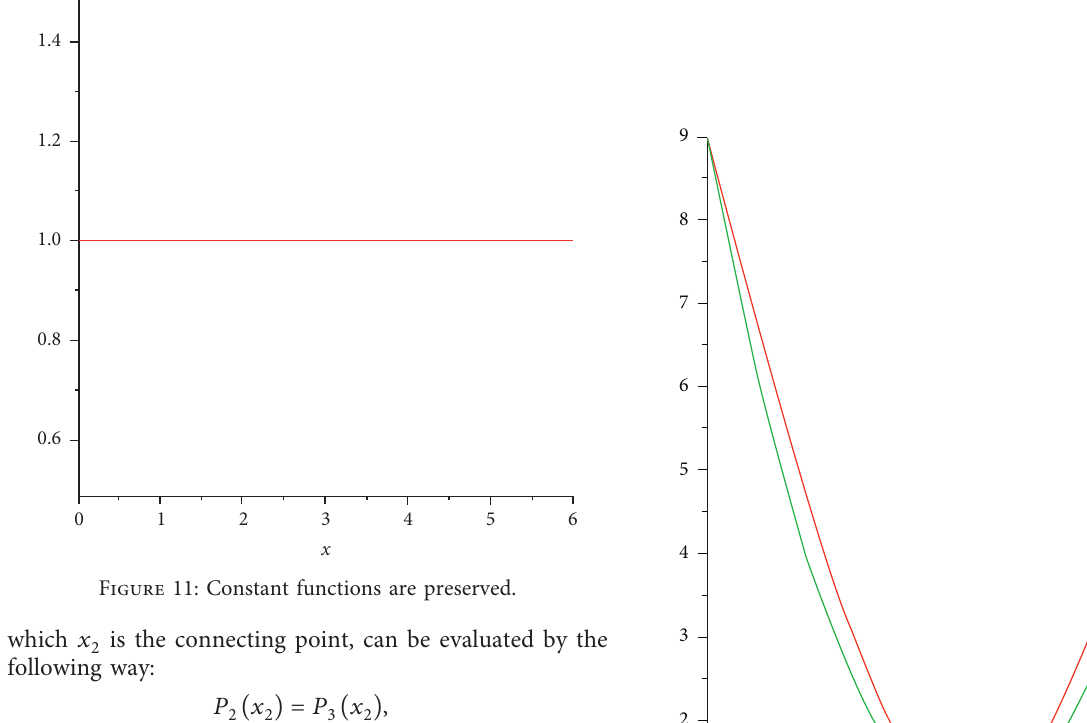
Figure 10: After application of the newly adopted